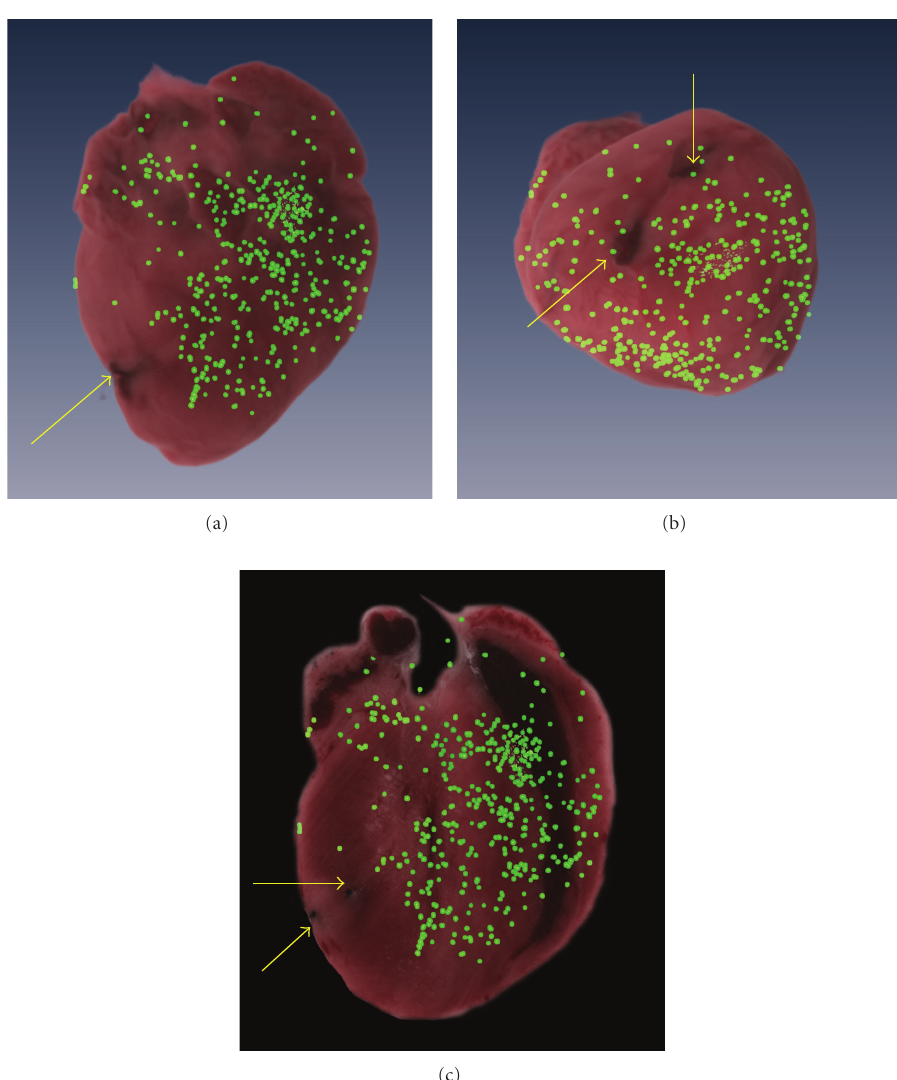
Figure 8: 3D volume renderings of MSC locations in the heart. Model-based processing was used to perform segmentation, quantification, and localization of quantum dot-labeled MSC’s in an infarcted heart. A 3D volume rendering of brightfield images of the heart is shown with a 3D volume rendering of MSC location 24 hours after a tail vein injection of 100,000 MSCs. MSCs were injected immediately following ligation of the LDA. MSC location was found to correspond to local blood flow in the infarcted heart. A long-axis (a) and short-axis (b) view of the heart shows cells located primarily on the right side of the heart. A corresponding long-axis 2D slice is shown along with a volume rendering of MSC location (c). In all images, the suture locations are visible